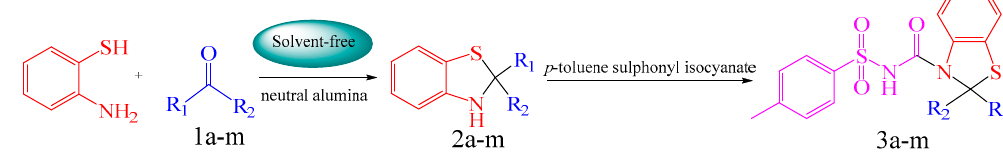
Scheme 3. Route for synthesis of the target compounds 3